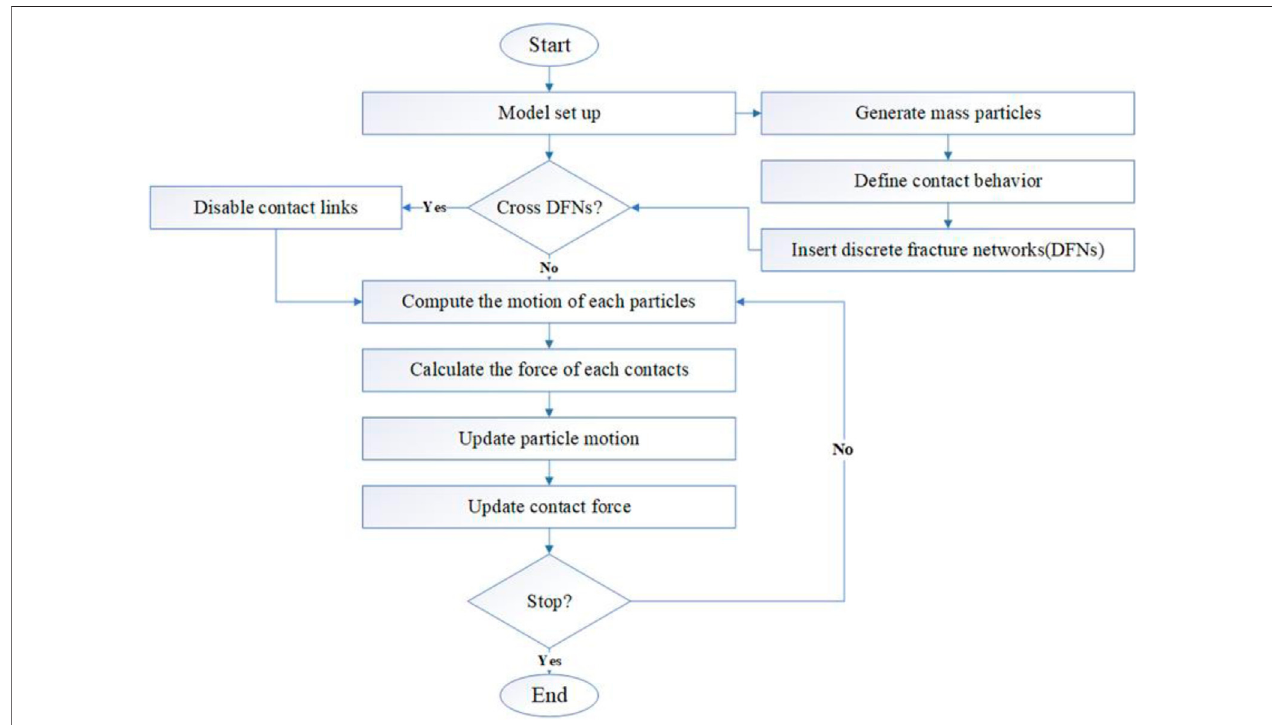
FIGURE 3 | Flowchart for DEM-DFN modeling.